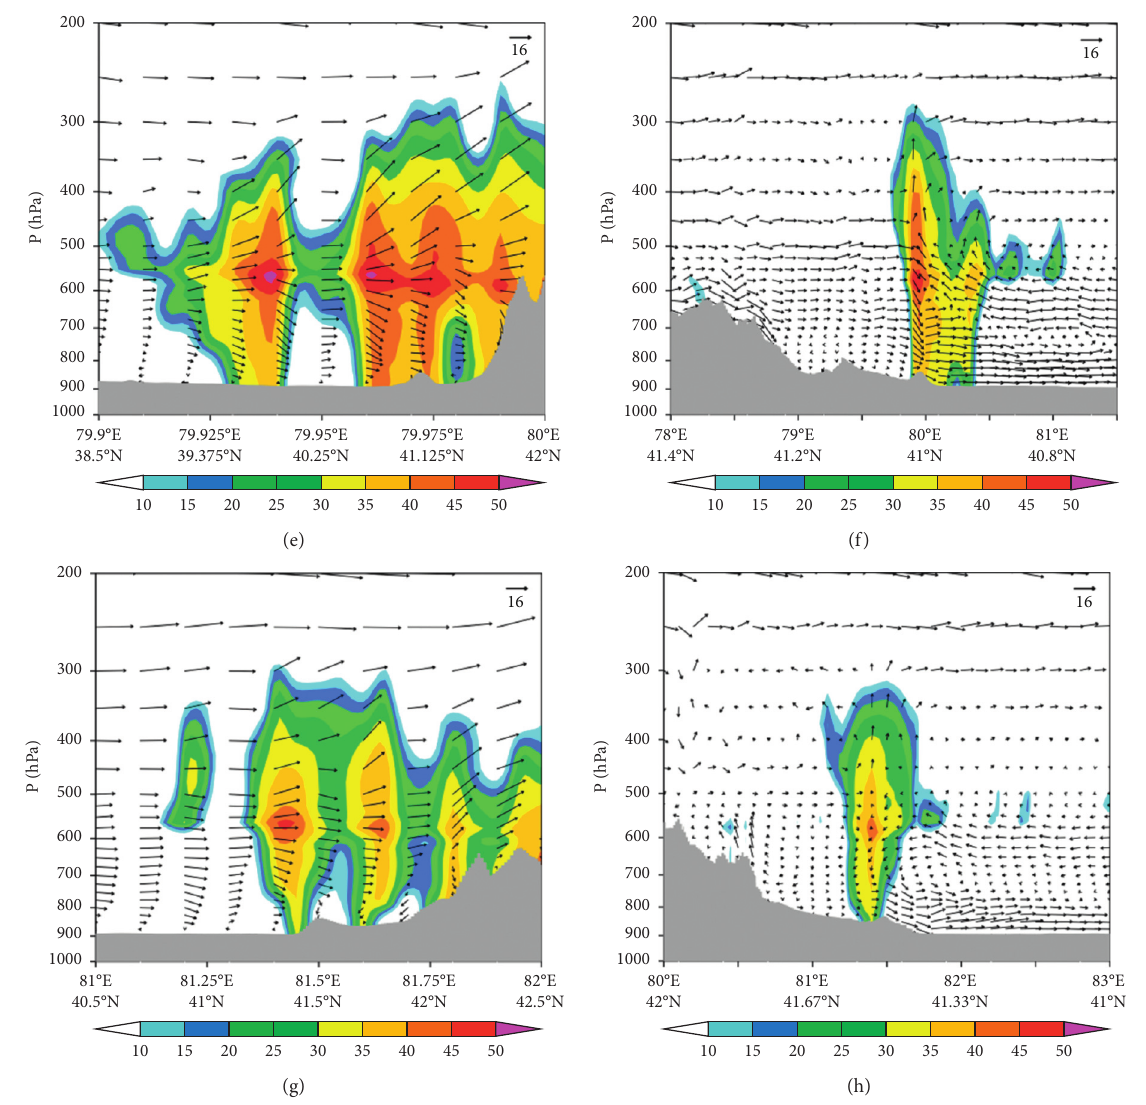
Figure 7: Vertical cross sections of simulated radar reflectivity (shaded, unit: dBZ) and wind vectors (arrow, unit: m · s − 1 ; for the convenience of analysis, the vertical velocity is multiplied by 10, and gray shading represents the terrain of the Tianshan Mountains, the same as below) along the black solid line shown in Figure 5. (a) Along AB in the initiation stage at 12:00 on July 31. (b) Along CD in the initiation stage at 12: 00 on July 31. (c) Along AB in the development stage at 16:00 on July 31. (d) Along CD in the development stage at 16:00 on July 31. (e) Along AB in the maturity stage at 17:30 on July 31. (f) Along CD in the maturity stage at 17:30 on July 31. (g) Along AB in the extinction stage at 22: 00 on July 31, 2016. (h) Along CD in the extinction stage at 22:00 on July 31,